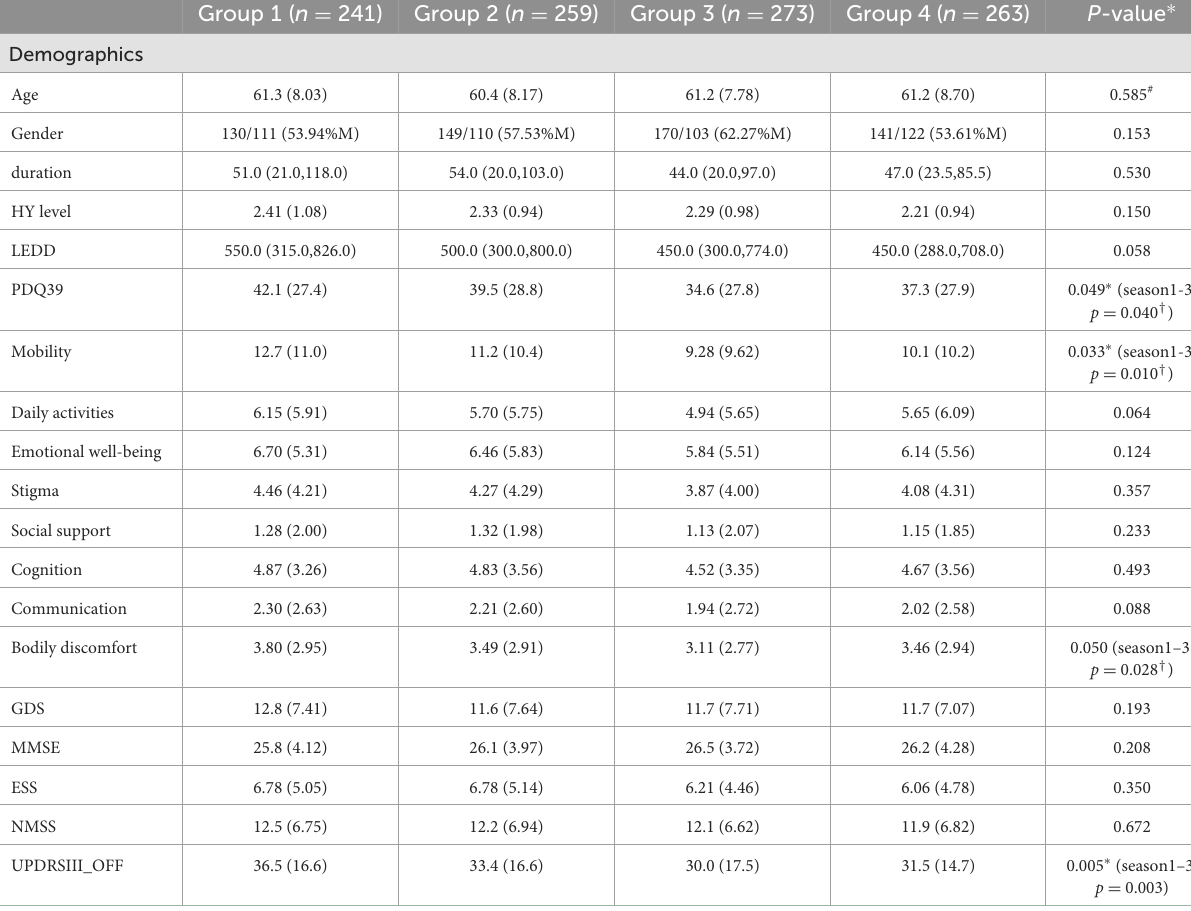
TABLE 1 Demographics and seasonal variations for PDQ-39 and other scale